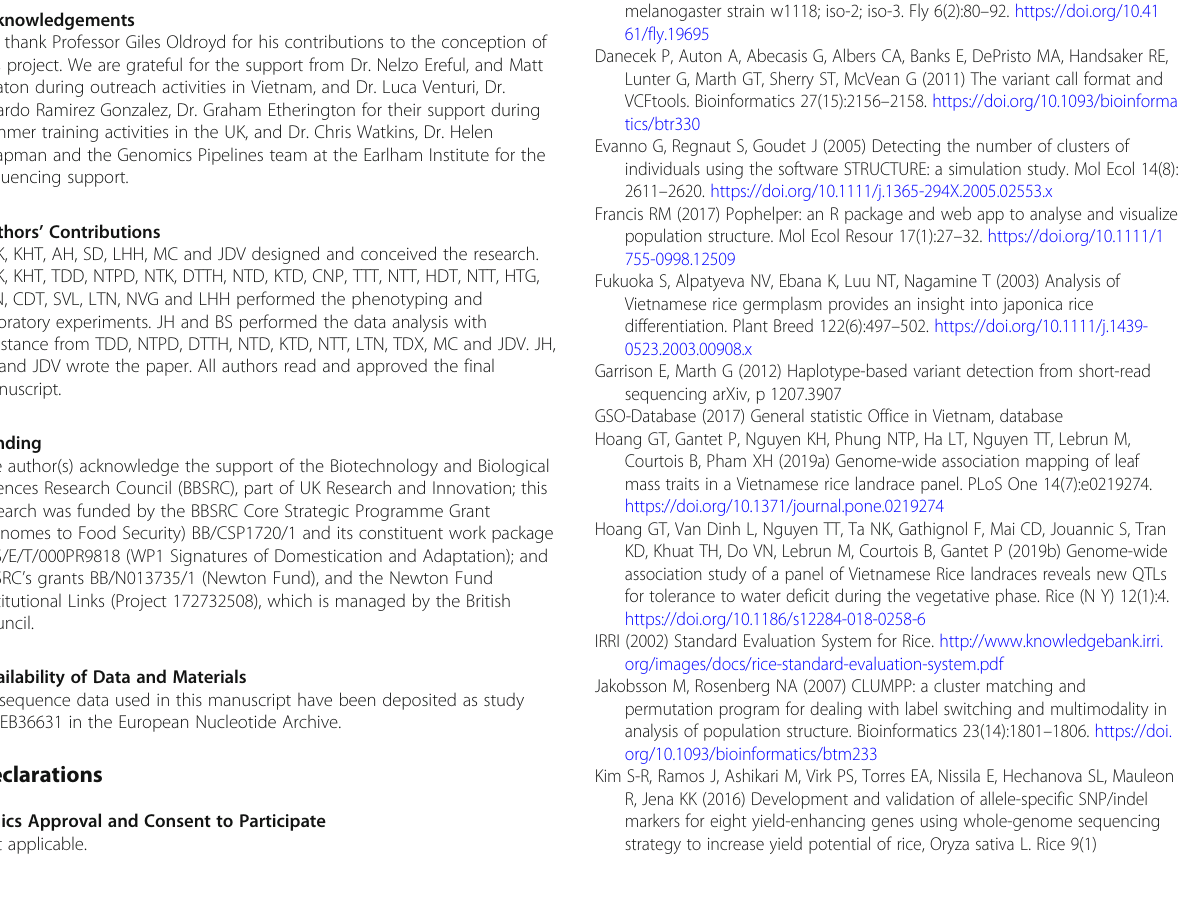
Additional file 3: Figure S17 . GWAS Manhattan and qq plots for the full panel and Indica and Japonica subpanels for Grain Length, Grain Width, Grain length-to-width ratio, Heading Date, Culm Strength, Leaf Length and Leaf Width. Additional file 4: Figure S18 . GWAS Manhattan and qq plots for the full panel and Indica and Japonica subpanels for Leaf Pubescence, Culm Number, Diameter Internode, Culm Length, Panicle Length and Floret